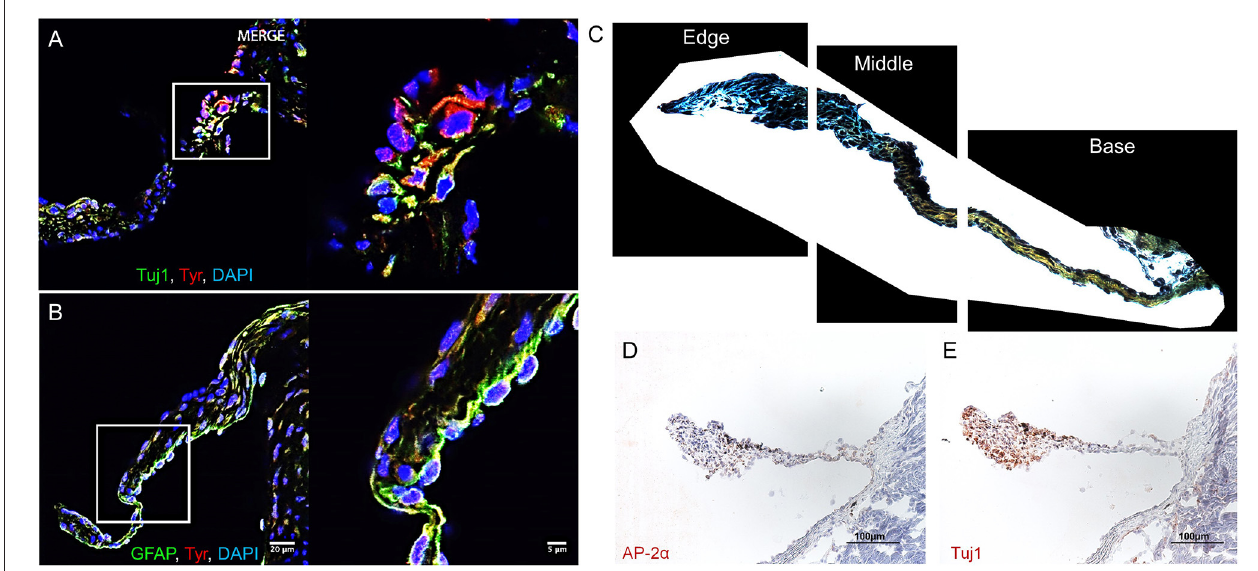
FIGURE 1 | Aortic valve (AV) interstitial cell (VIC) phenotypes. Melanocytic, neuronal, and glial proteins in mouse AV leaflets. Immunofluorescence on mouse AV tissue sections for (A) the neuronal marker tubulin beta 3 class III (Tuj1), tyrosinase (Tyr), and cell nuclei (DAPI); (B) the glial marker glial fibrillary acidic protein (GFAP), Tyr, and DAPI. Scale = 20 µ m for large and 5 µ m for magnified immunofluorescence images. (C) Representative image of leaflet sectioned into thirds by area using a custom image analysis script. (D) Immunohistochemistry of the glial marker AP-2 α and (E) Tuj1. Scale = 100 µ m for immunohistochemistry